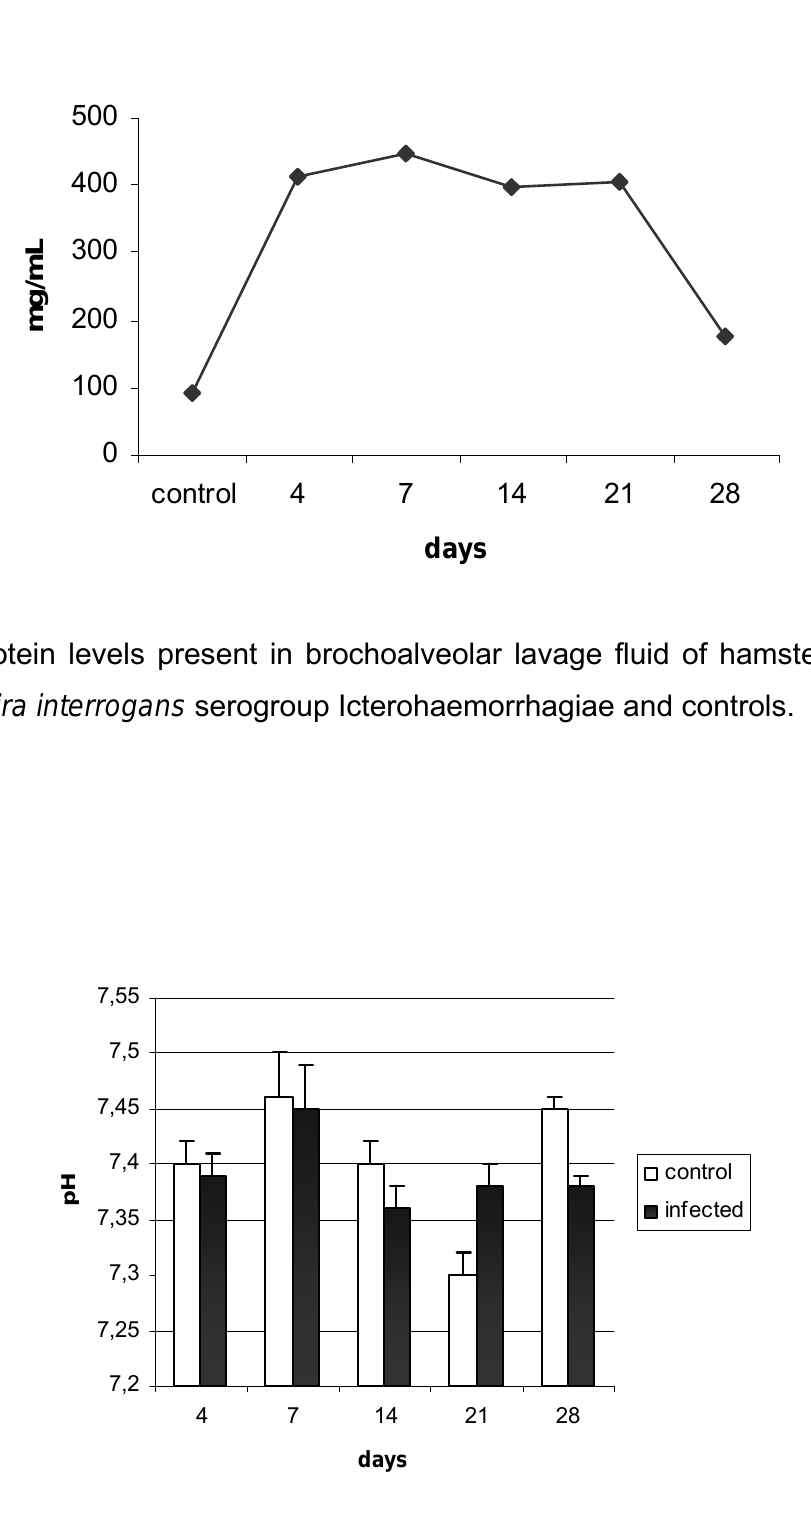
Figure 6. Mean pH (±SD) in blood samples from hamsters inoculated with Leptospira interrogans Icterohaemorrhagiae and their respective control